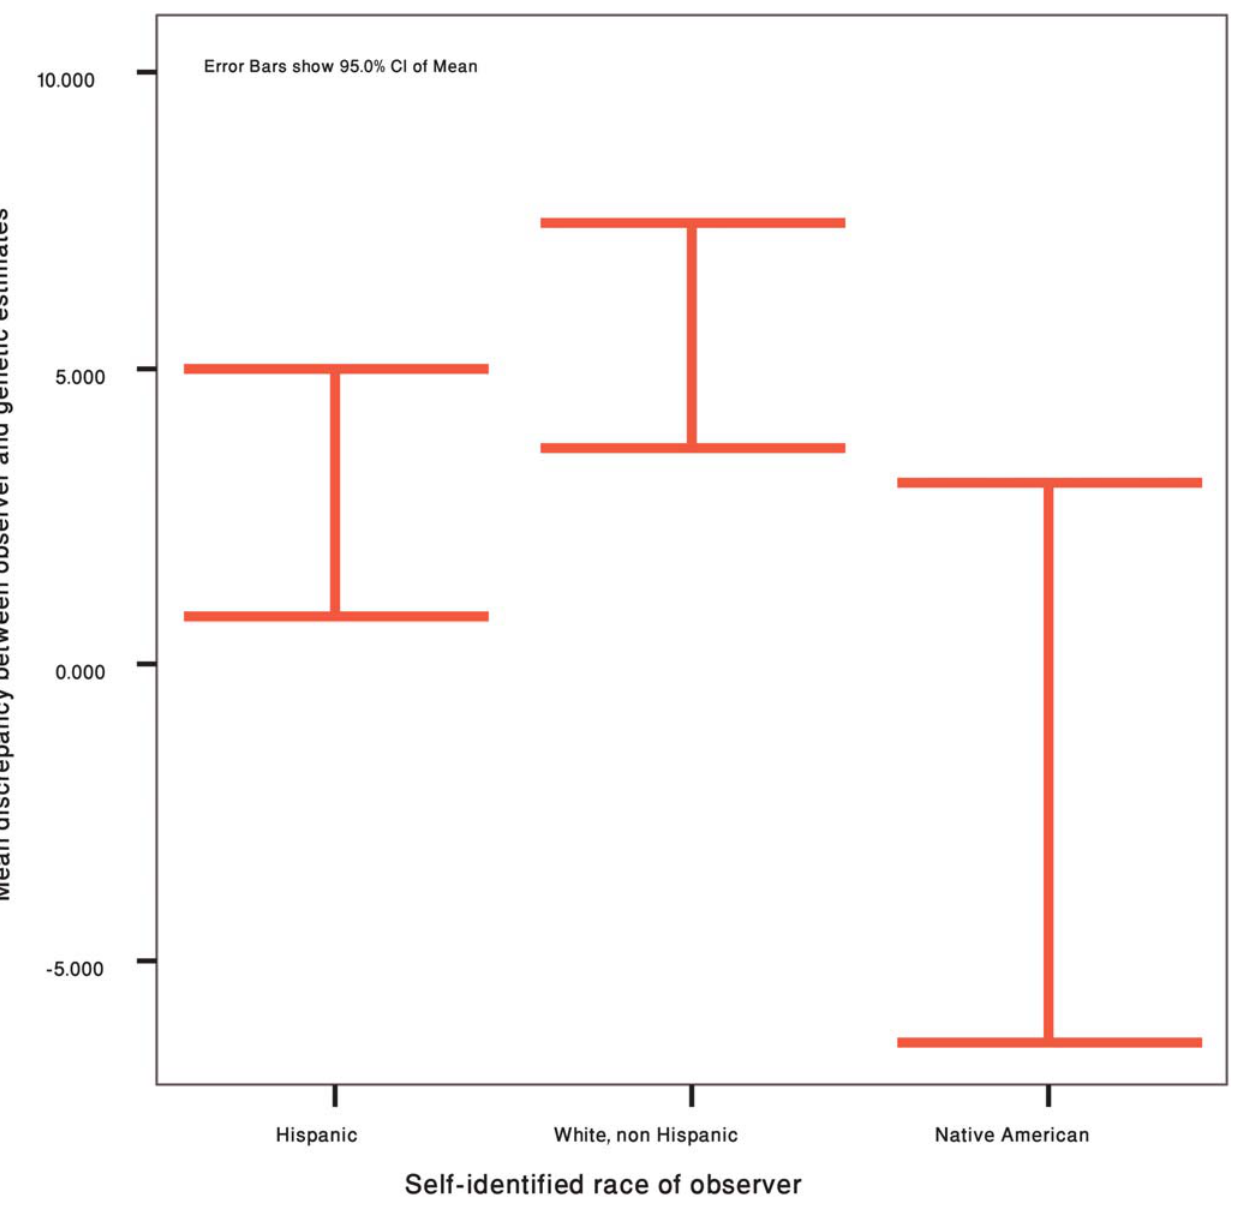
Figure 3. Averaged difference between observer and genetic estimates by self-identified race of observer. Positive values indicate an overall overestimation of NA ancestry by the observers, compared to the genetic estimates. Error bars show 95% CI of Mean.